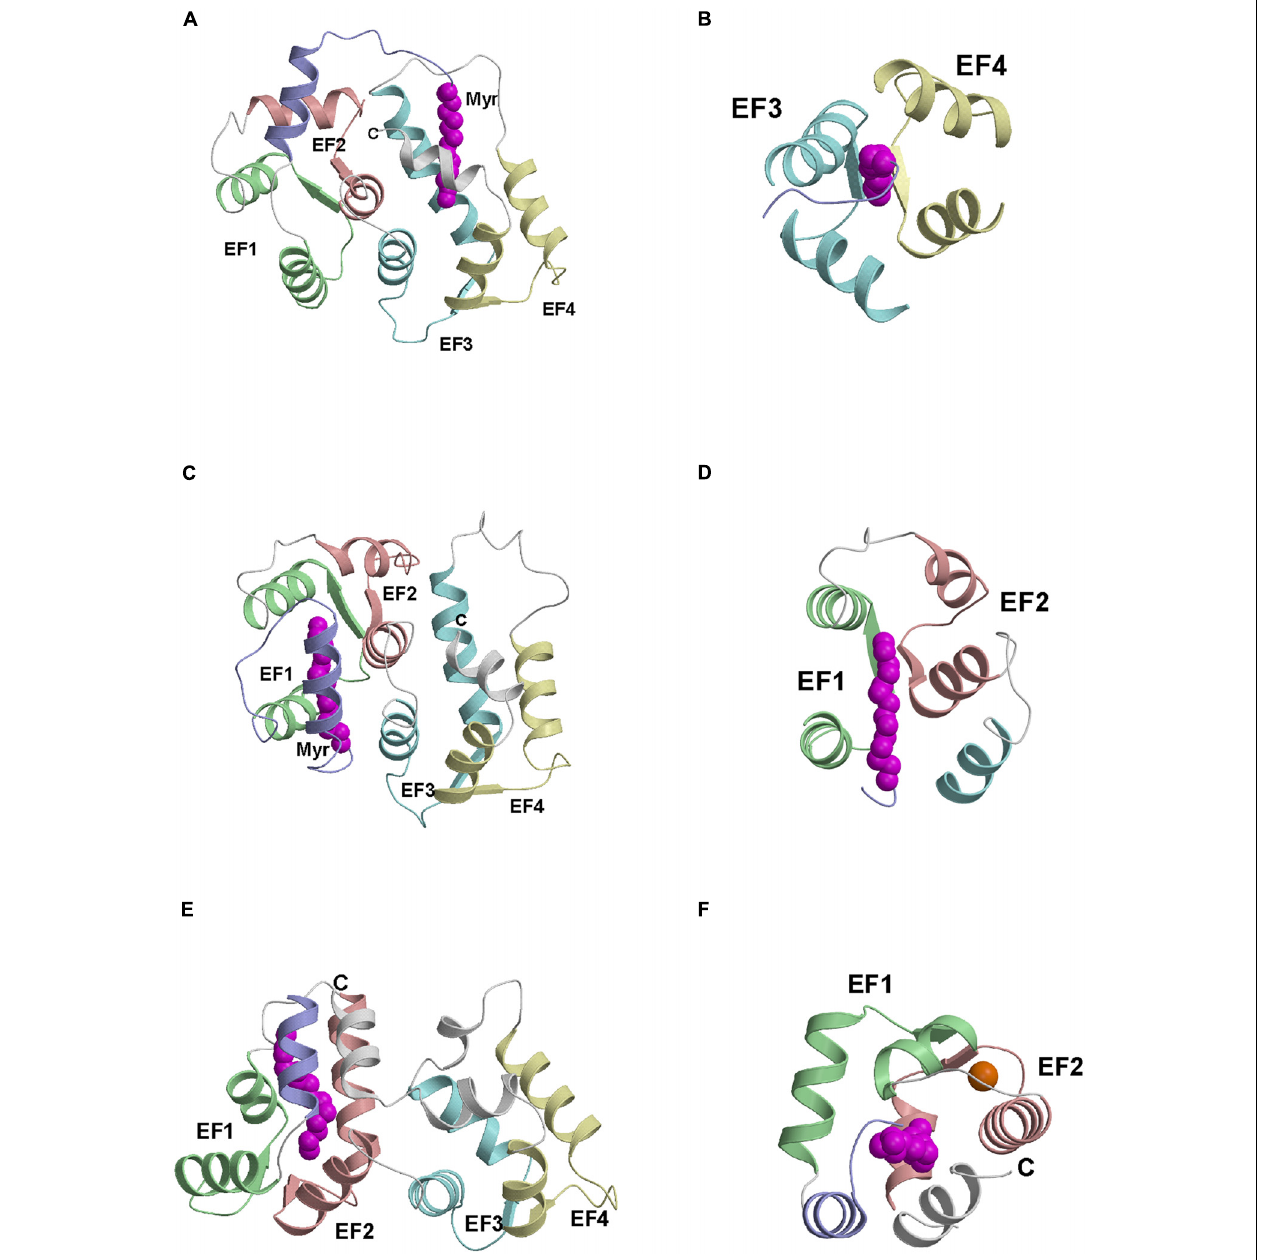
FIGURE 2 | Main chain structures of Ca 2+ -free myrisoylated NCS-1 (PDB ID: 212e) (A), recoverin (PDB ID: 1iku) (C), and GCAP1 (PDB ID: 2r2i) (E). Close-up views of the myristate binding pocket in NCS-1 (B) , recoverin (D) and GCAP1 (F) . EF-hands and myristoyl group (magenta) are colored as defined in Figure 1 . Adapted from and originally published by Lim etal. (2011).